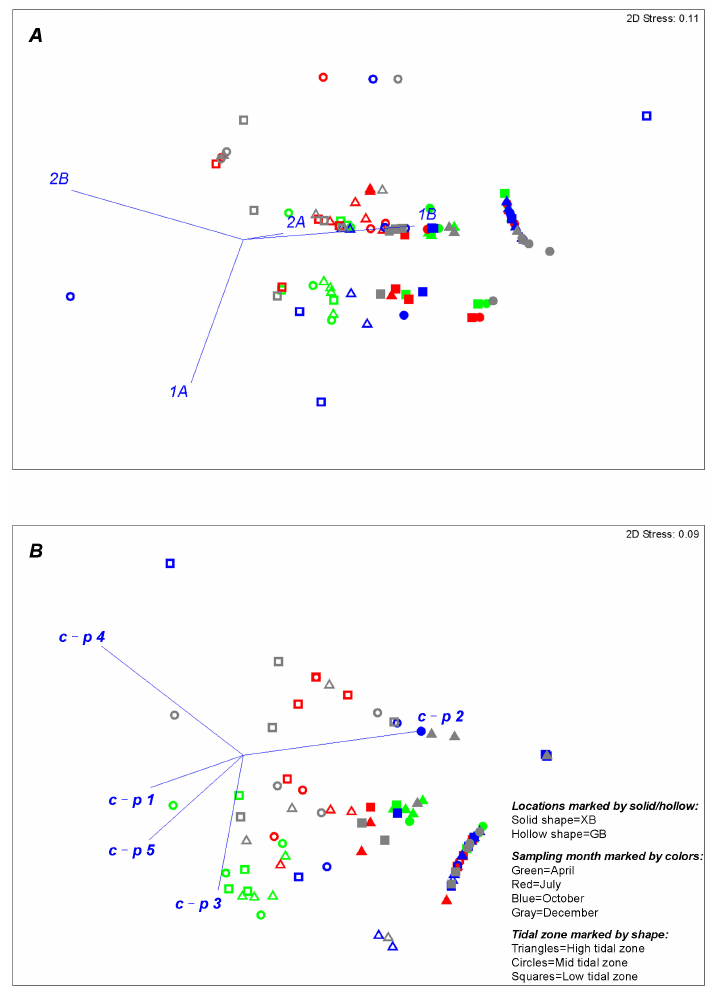
Figure 6. nMDS plots of feeding types ( A ) and c–p classes ( B ) data of nematodes at study locations over different sampling months. Vectors overlain on plot show correlations of traits, indicating important traits that differentiate the assemblages.